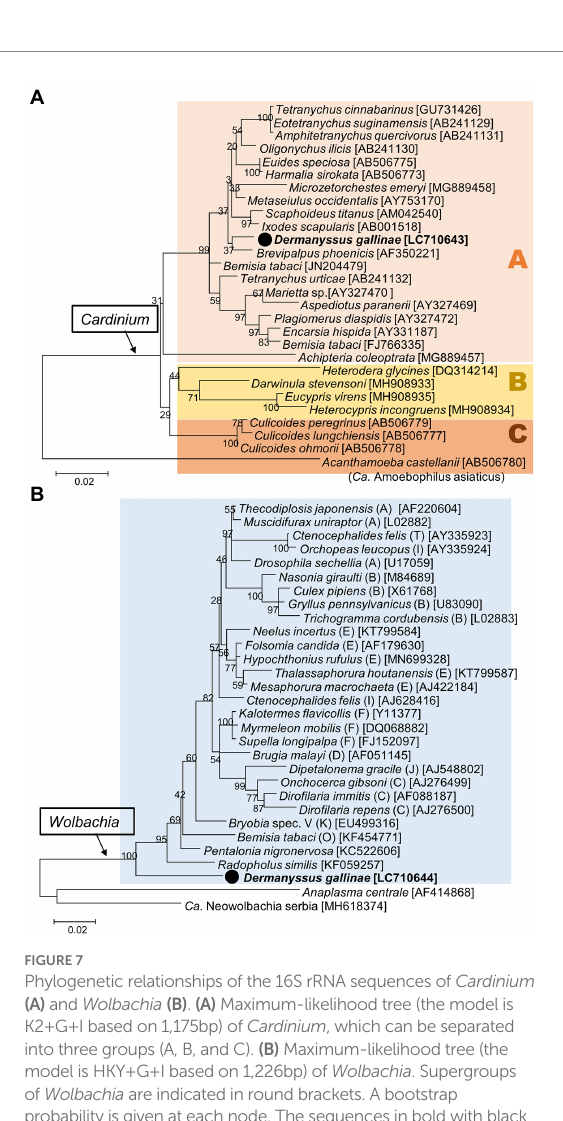
FIGURE 7 Phylogenetic relationships of the 16S rRNA sequences of Cardinium (A) and Wolbachia (B) . (A) Maximum-likelihood tree (the model is K2 + G + I based on 1,175 bp) of Cardinium , which can be separated into three groups (A, B, and C). (B) Maximum-likelihood tree (the model is HKY + G + I based on 1,226 bp) of Wolbachia . Supergroups of Wolbachia are indicated in round brackets. A bootstrap probability is given at each node. The sequences in bold with black circle are those obtained in this study. Numbers in square brackets indicate NCBI accession numbers.